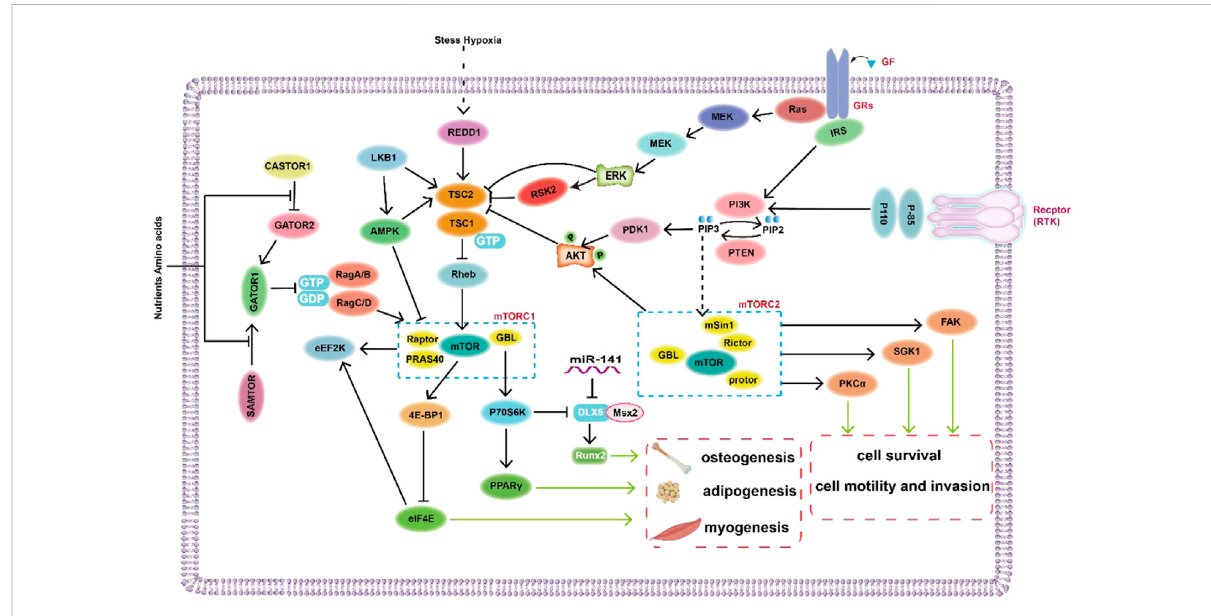
FIGURE 2 Diagram of the regulatory mechanism of mTOR signaling pathway in mesenchymal stem